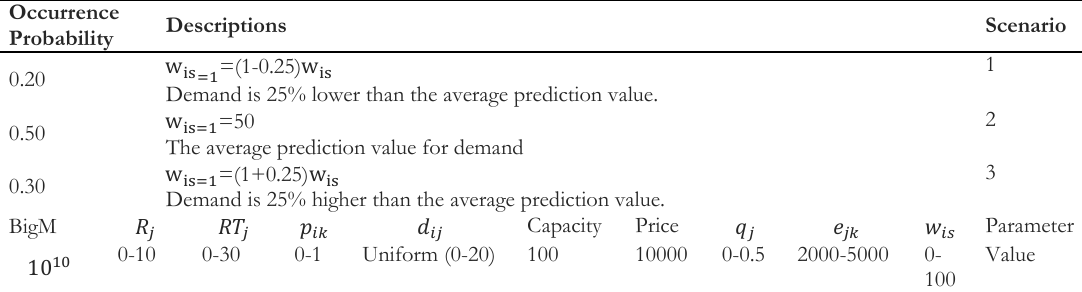
Table 2. Demand for every scenario and values of